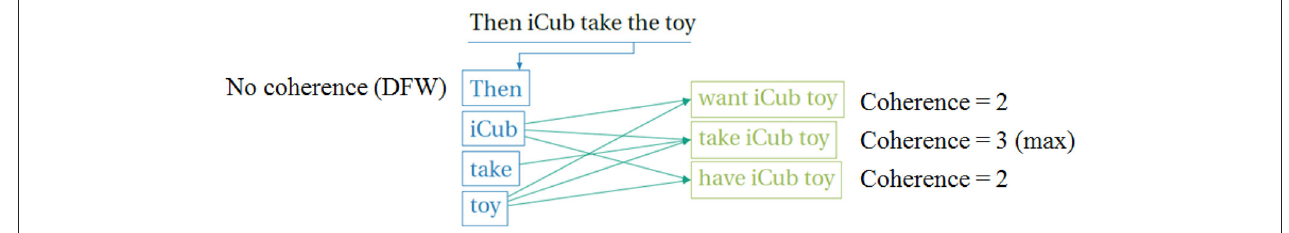
FIGURE 5 | Calculating coherence between sentence in narrative and meanings in Situation Model during creation of the training corpus for the Narrative Construction reservoir models. To match the sentence with the appropriate meaning we calculate coherence as the number of matches between open class words in the sentence, and in the candidate meanings. The meaning atom with maximum coherence is selected as the meaning corresponding to the sentence. Words that have no match in the meaning are candidate narrative function words. DFW, discourse function word or narrative function word.